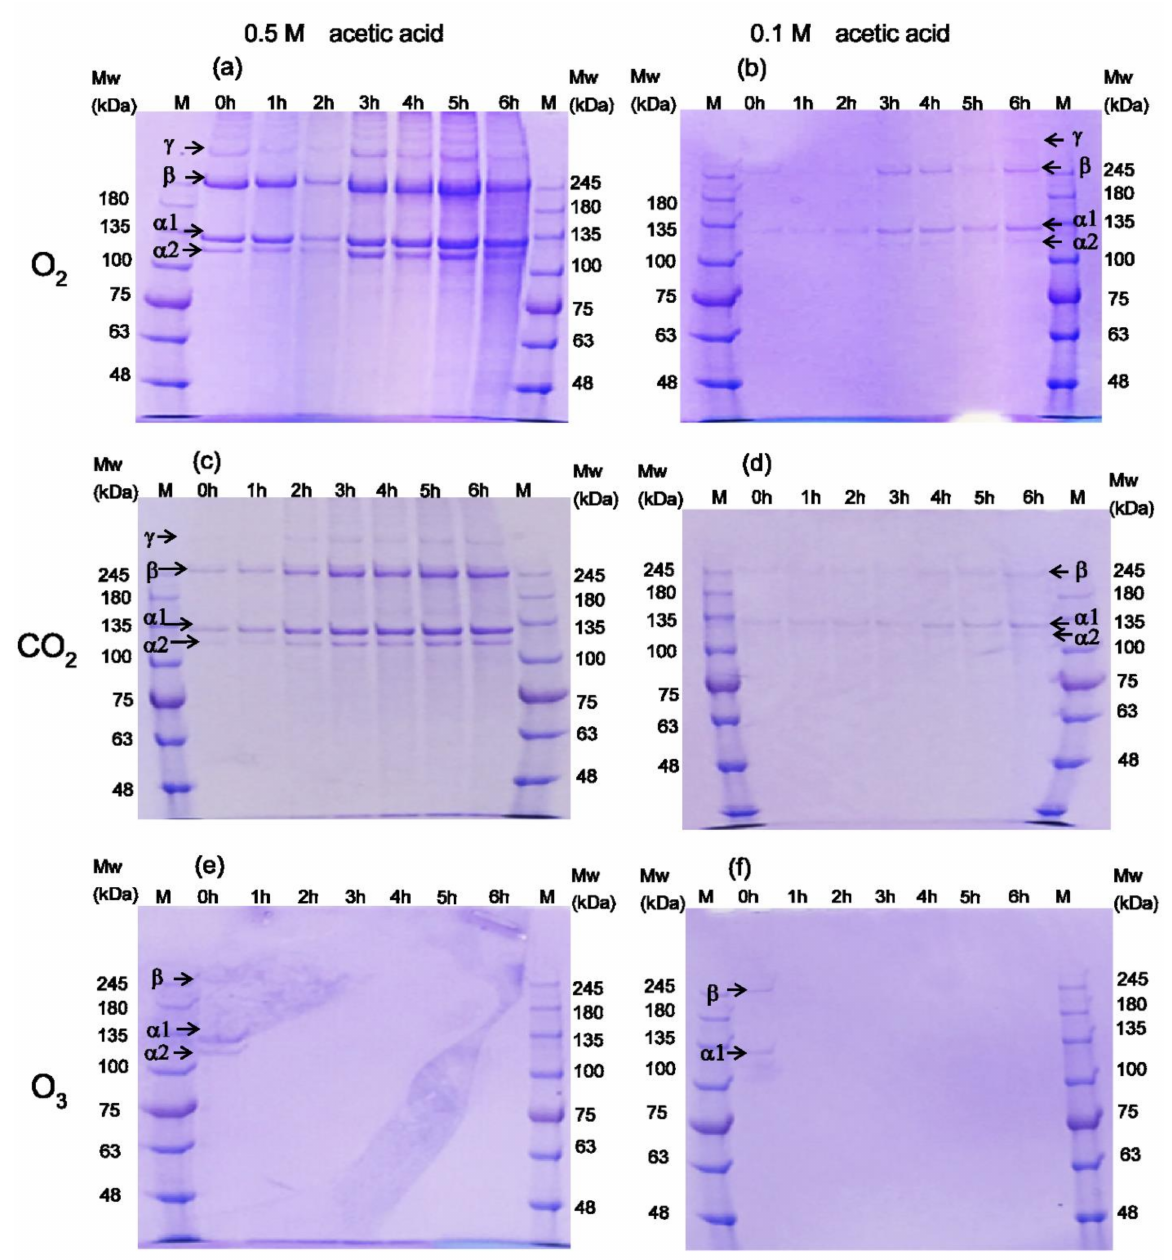
Figure 1. SDS-PAGE analysis of collagen extracted from tilapia scales using different acetic acid concentrations and gases: ( a ) 0.5 M acetic acid, O 2 ; ( b ) 0.1 M acetic acid, O 2 ; ( c ) 0.5 M acetic acid, CO 2 ; ( d ) 0.1 M acetic acid, CO 2 ; ( e ) 0.5 M acetic acid, O 3 ; and ( f ) 0.1 M acetic acid, O 3 . The outer lanes are markers, and the inner lanes labeled from 0 to 6 h indicate the gas bubbling time. The α 1, α 2 chains, β chain, and γ chain are shown in panel ( a – c ). The α 1, α 2 chains and β chain are shown in panel ( d , e ). The α 1 chains and β chain are shown in panel ( f